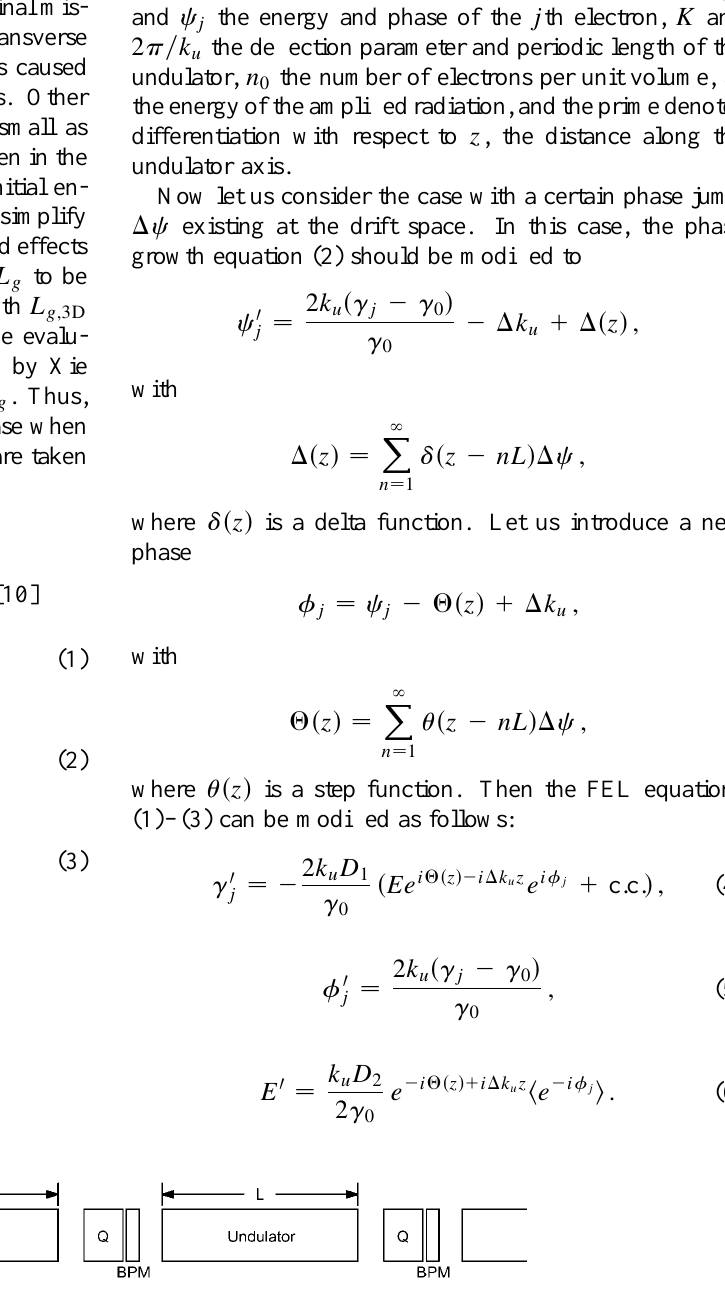
FIG. 1. Undulator composed of several segments with the length of L . In the drift sections, focusing magnets (indicated by Q) and beam position monitors (BPM) are installed.